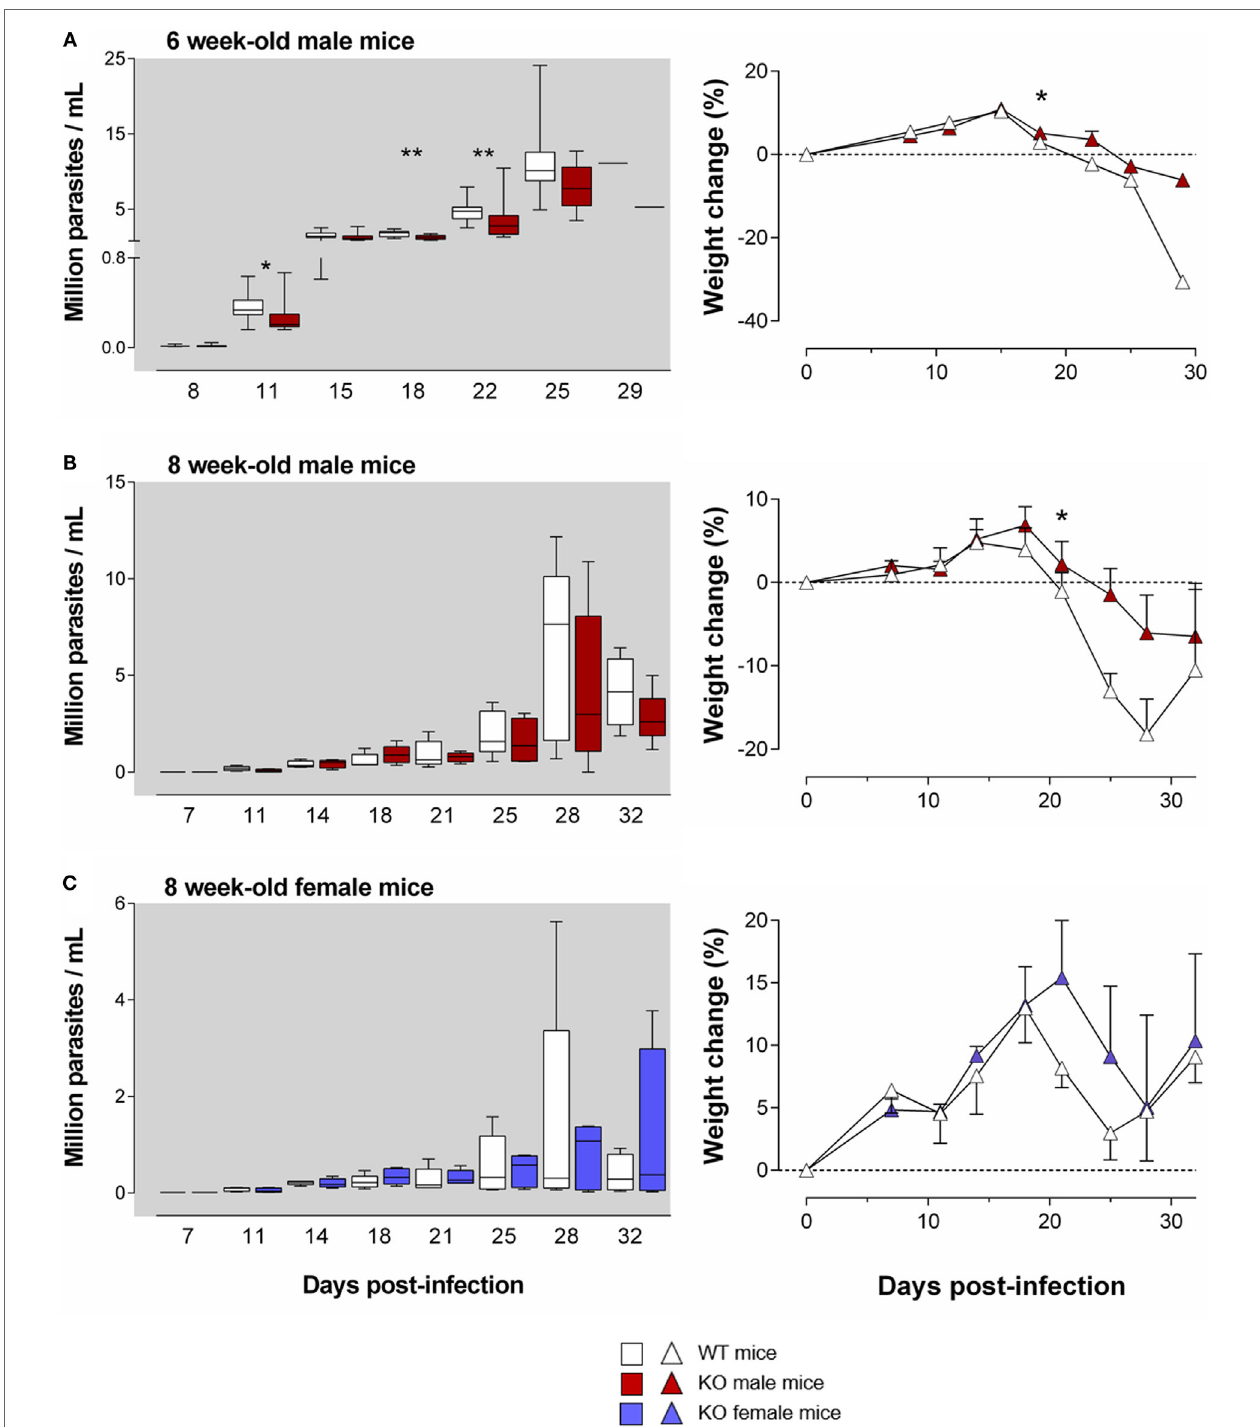
FigUre 3 | The harmful effect of the ly49e receptor on the course of T. cruzi infection weakens with mouse age . WT and Ly49E KO were inoculated s.c. with 100 trypomastigotes at day 0 at the age of 6 (a) or 8 weeks (B,c) . Blood parasitemia levels were determined at the indicated time points (left panels). Right panels – body weight changes at the indicated days after infection, relative to the initial weight at the time of infection. Results are expressed as Box and Whiskers showing the median from 14 WT and 14 KO 6-week-old mice (a) , 5 WT and 5 KO 8-week-old male mice (B) and 5 WT and 5 KO 8-week-old female mice (c) . Statistically significant differences between WT and Ly49E KO mice are indicated with * p ≤ 0.05 and ** p < 0.01 (Mann–Whitney U